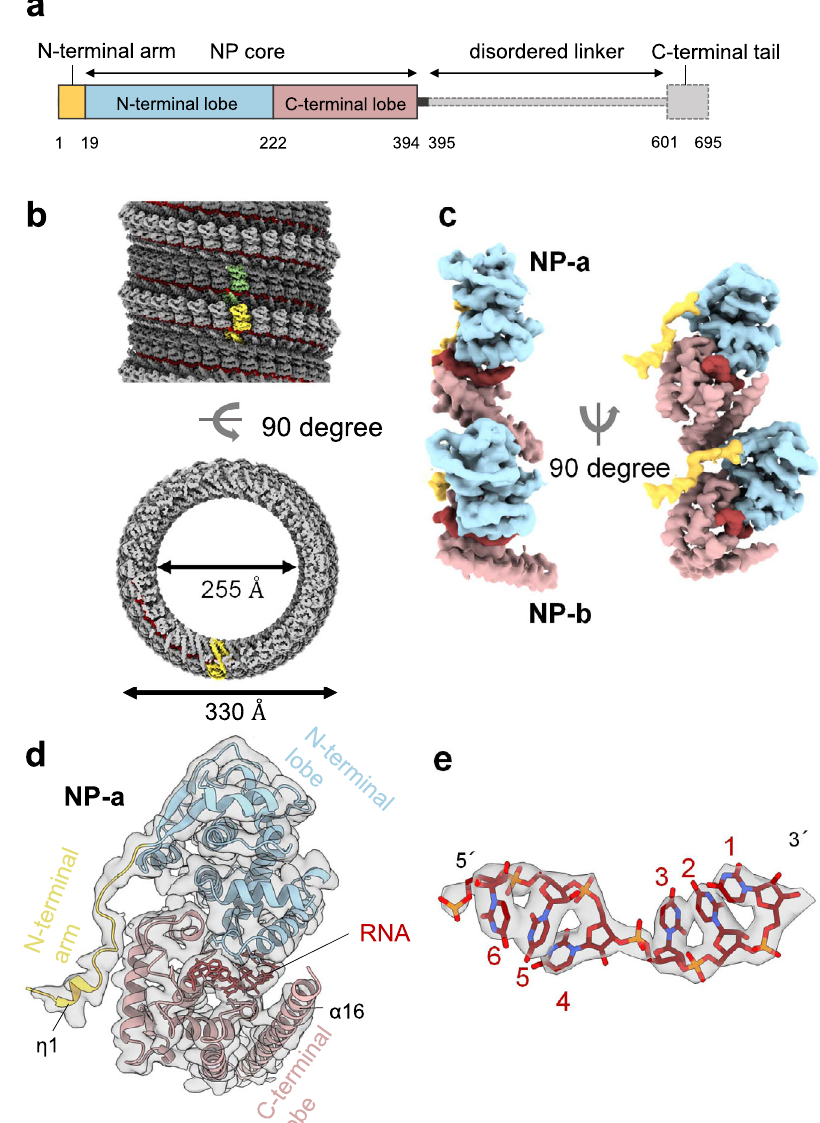
Fig. 1 Overall cryo-EM structure and atomic model of MARV nucleoprotein (1 – 395). a Structural layout of MARV NP sequence. The full-length NP consists of 695 amino acids and is divided into an N-terminal arm, an NP core consisting of N- and C-terminal lobes, a disordered region, and a C-terminal tail. b The iso-electron potential surface map of an NP – RNA complex reconstruction, calculated from 23,545 segments (contoured at 3 σ above average). The RNA strand is highlighted in red. An NP-a molecule, which is in a dark gray strand, is highlighted in light green. An NP-b molecule in a light gray strand is highlighted in yellow. c The isolated NP – RNA complex unit (3 σ ) and d our atomic model with the EM map (3 σ ) in a ribbon representation, colored the same as in Fig. 1a. e Isolated EM map (6 σ ) of RNA superimposed with the atomic model. RNA bases are modeled as